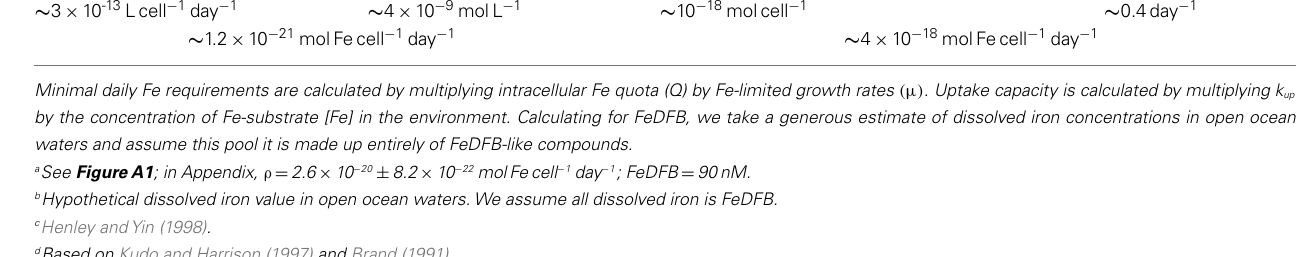
Table 1 |A comparison between the minimal daily Fe requirements and the daily FeDFB uptake capacity of Synechococcus spp. Daily FeDFB uptake capacity: k up × [Fe] Minimal daily Fe requirement: Q × μ [Fe] − Q − μ − Fe-substrate concentration b intracellular Fe quota for Synechococcus spp. c Fe-limited growth rate